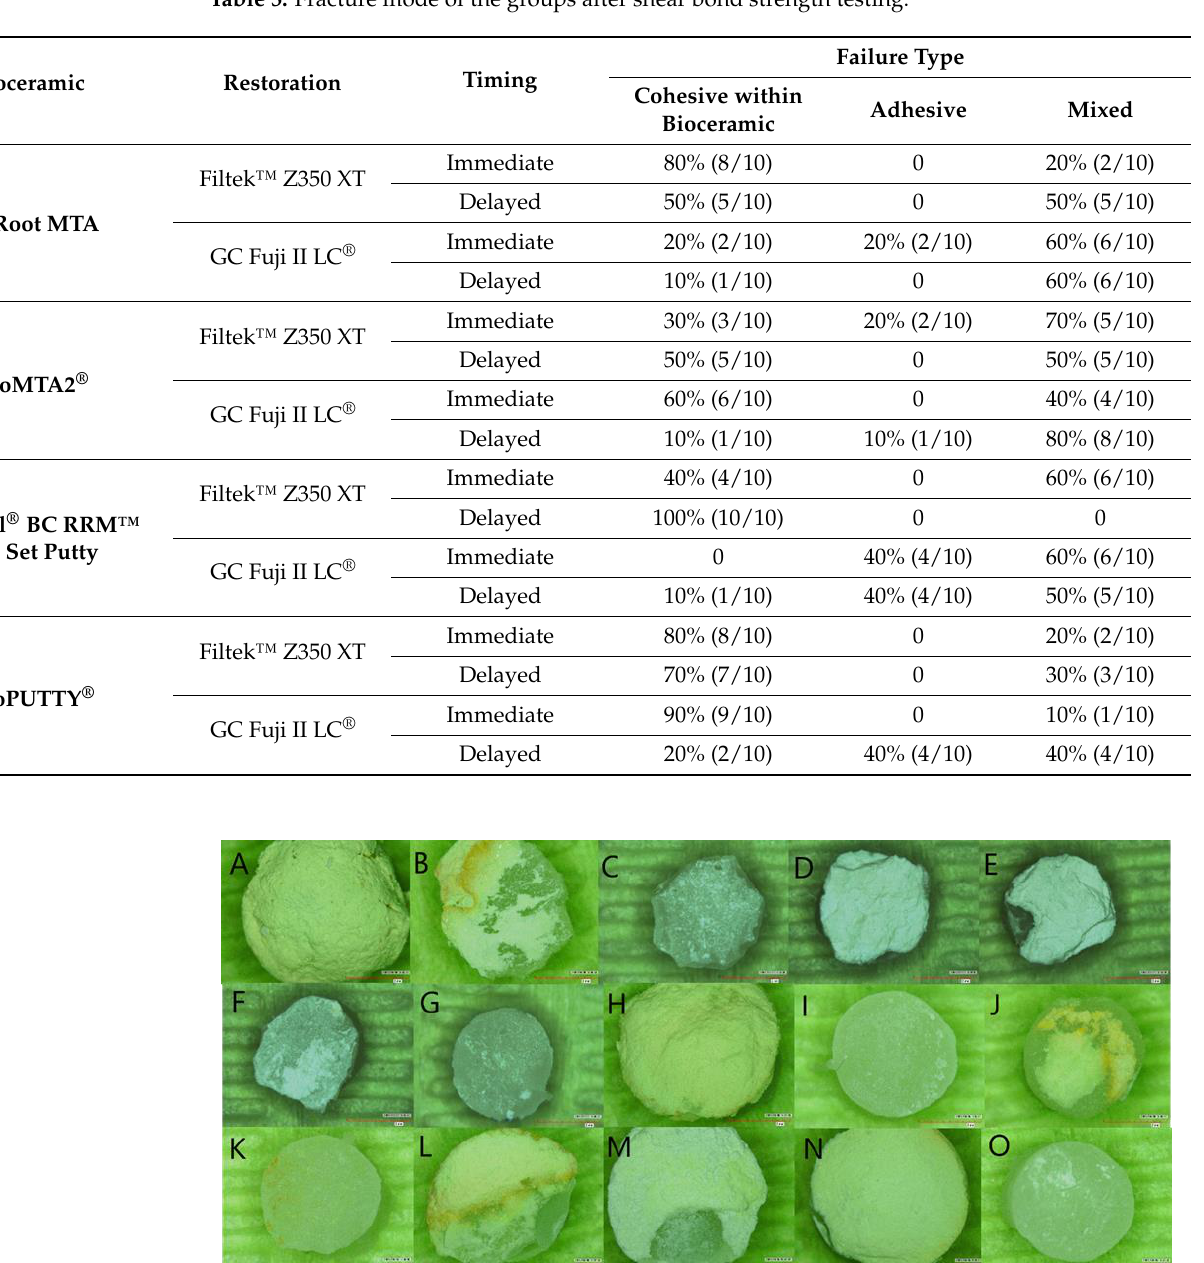
Table 5. Fracture mode of the groups after shear bond strength testing.